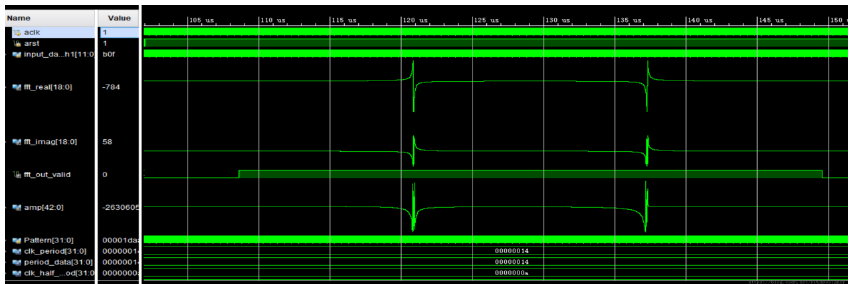
Fig. 6. Radix-2 FFT simulation of 15MHz